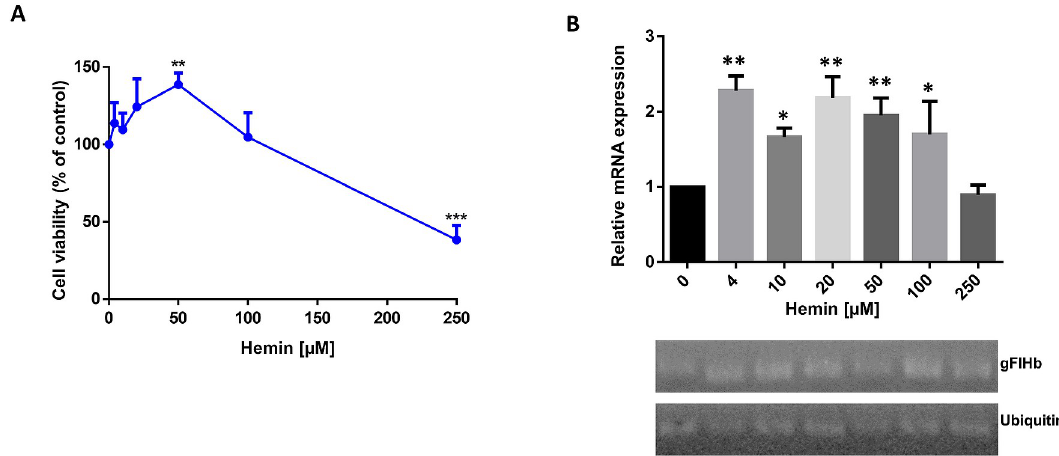
Fig 3. Effect of hemin on cell viability and gFlHb expression in G . duodenalis WB-DMF trophozoites. (A) Cell viability of trophozoites exposed to increasing hemin concentrations. (B) RT-PCR analysis of gFlHb transcript levels. The values represent the ratio of the optical densities of the PCR bands of gFlHb and internal standard ubiquitin. Densitometry values are the mean corresponding to n = 3 independent experiments. An asterisk denotes a statistically significant difference ( � p < 0.05, �� p < 0.01 and ��� p < 0.001), as determined by ANOVA test.